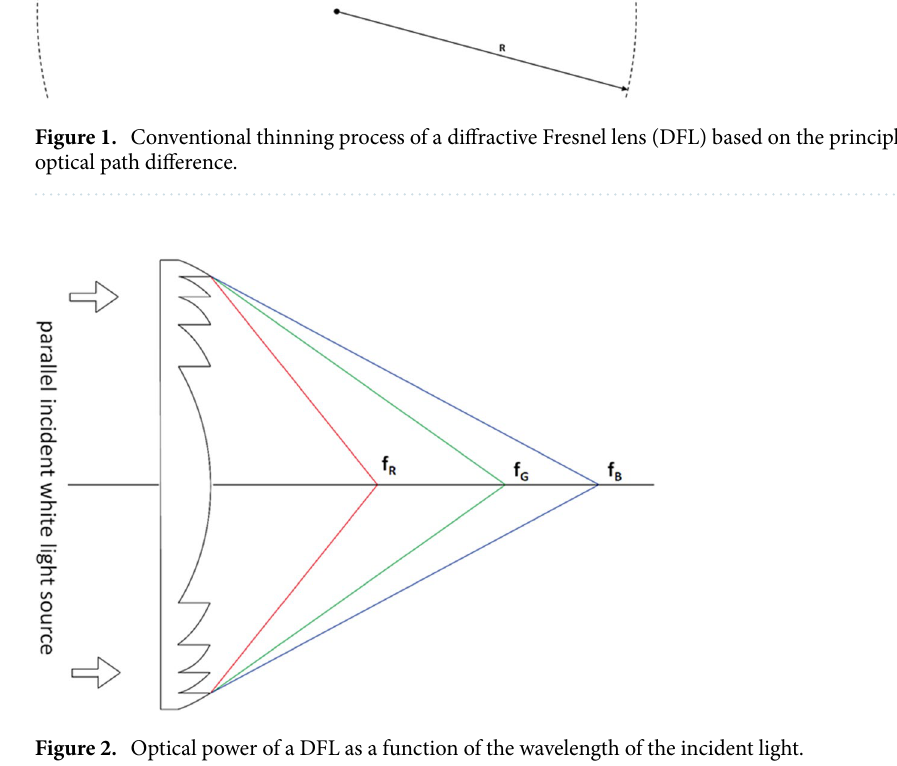
Figure 2. Optical power of a DFL as a function of the wavelength of the incident